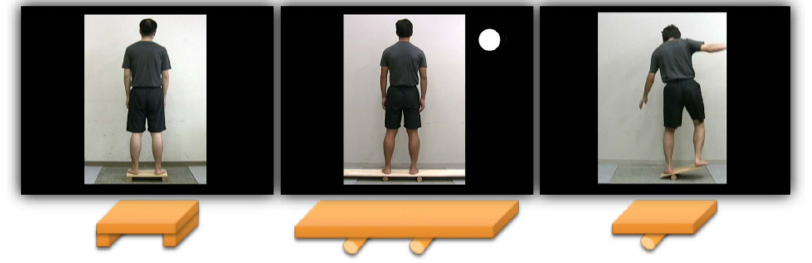
Fig. 1. Three kinds of wooden balance boards used in the present experiment. The participant was instructed to stand and maintain his balance on three kinds of wooden balance boards: Two quadrangular pillars (statically stable) (left), two round pillars (dynamically stable) (middle), and the one round pillar (dynamically unstable) (right). A white circle was marked on the right above the self